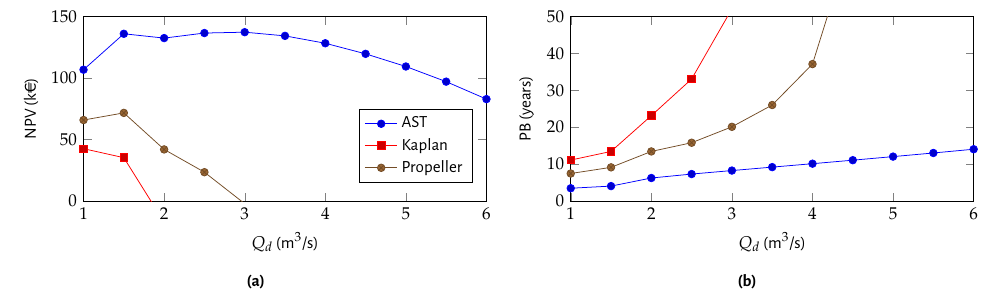
Figure 8. Parameters comparison between AST, Kaplan and Propeller turbines; ( a ) NPV; ( b ) PBP. The best solution obtained for each technology is presented in Table 1. The Kaplan turbine is the technology that operates more time, due to its wide range of discharges, yet, it has the lowest NPV, the highest PBP and the lowest IRR due to its high capital and O&M costs. The Propeller turbine solution recovers almost the same energy as AST, but operates less time, due to the limited range of discharge. The AST solution is the one that has the lowest capital cost, the highest NPV and IRR and the lowest PBP. The AST with a design discharge of 3.0 m 3 /s leads to a NPV of 137.3 k A C in 20 years with a PBP of 8.3 years and an IRR of 13.7% (Figure 6). This solution corresponds to a rated power of 55 kW, harvested energy of 282 MWh/year and a capital cost of 160.7 k A C. Figure 5b) shows that the turbine can operate with a maximum power of 61 kW during 36% of the year and this power gradually decreases until 71% of the time. This means that the turbine will not be used during 29% of the year.